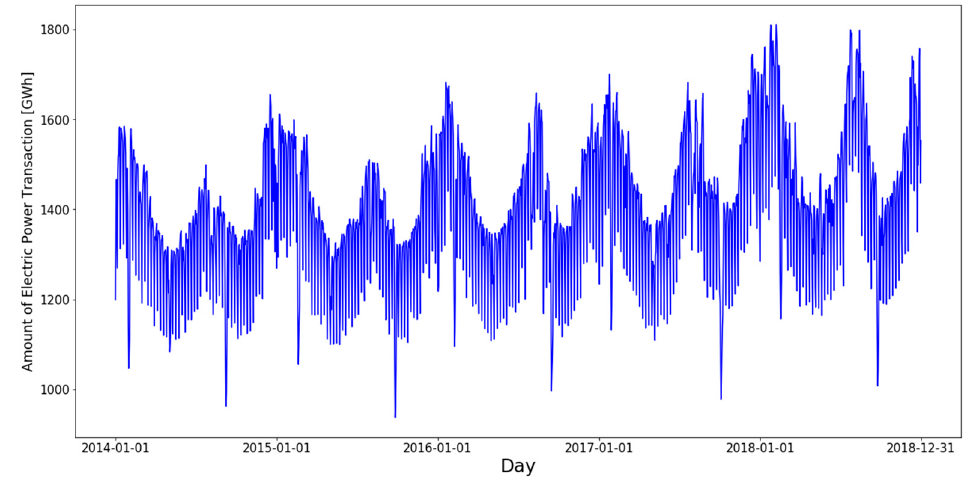
Figure 3. Amount of EPT in Korea from 2014 to 2018. Figure 3. A mount of EPT in Korea from 2014 to 2018. Figure 3. A mount of EPT in Korea from 2014 to 2018.